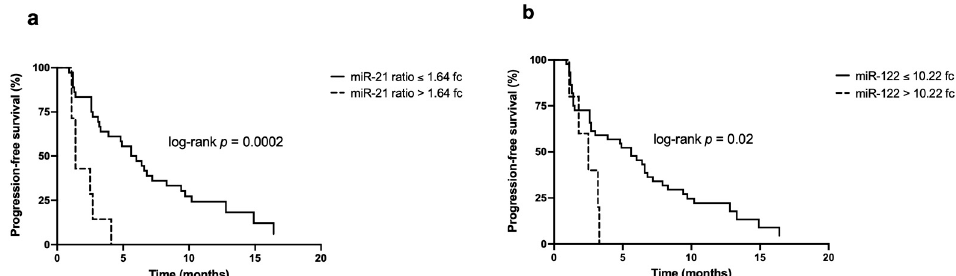
Figure 3. Kaplan–Meier curves for the PFS according to miR-21 ratio and miR-122 levels: ( a ) Patients with miR-21 ratio ≤ 1.64 fc have a significantly better PFS compared to patients with miR-21 ratio >1.64 fc (5.6 months [1.2–10.2] vs. 1.4 months [0.2–2.7]; p = 0.0002); ( b ) patients with miR-122 ≤ 10.22 fc have a statistically significant higher PFS compared to patients with miR-122 levels >10.22 fc (5.6 months [1.4–9.7] and 2.5 months [0.7–3.2]; p =